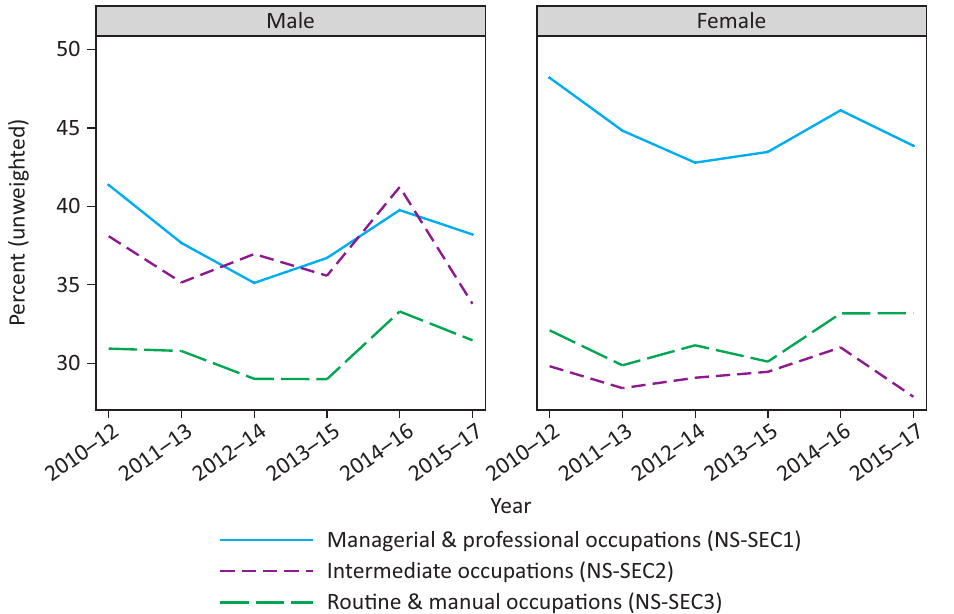
Figure 1. Participation in employer-provided training in last 12 months, by sex and own NS-SEC. Source: UKHLS waves 2–7,